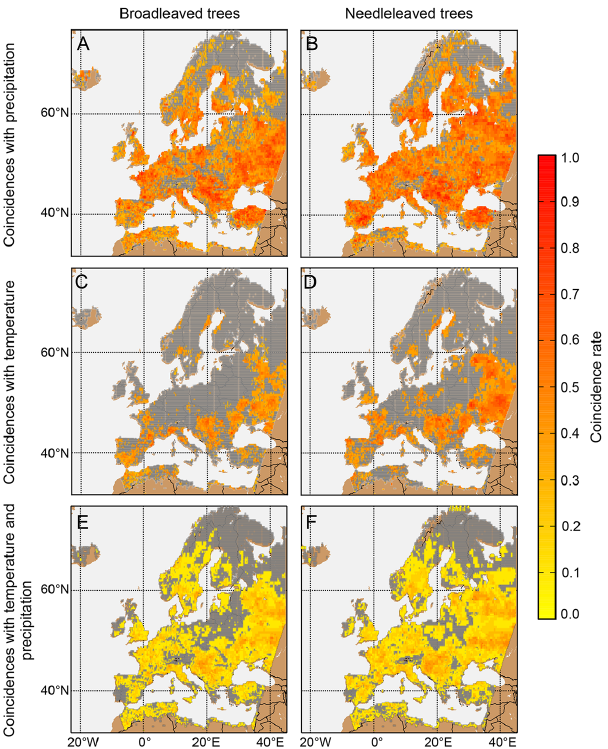
Figure 4. Map of coincidence rates between extremes in simulated NPP and precipitation for (a) broadleaved and (b) needle-leaved trees. Coincidence rates between extremes in simulated NPP and temperature for (c) broadleaved and (d) needle-leaved trees. Coinci- dence rates for simulated NPP and combined precipitation and tem- perature extremes for (e) broadleaved and (f) needle-leaved trees. The colour bar gives the coincidence rate r for the coincidence anal- ysis with (cid:49)t = 2. Only grid cells with significant coincidence rates are coloured; nonsignificant grid cells are marked in grey. Note that the significance level for each grid cell is determined